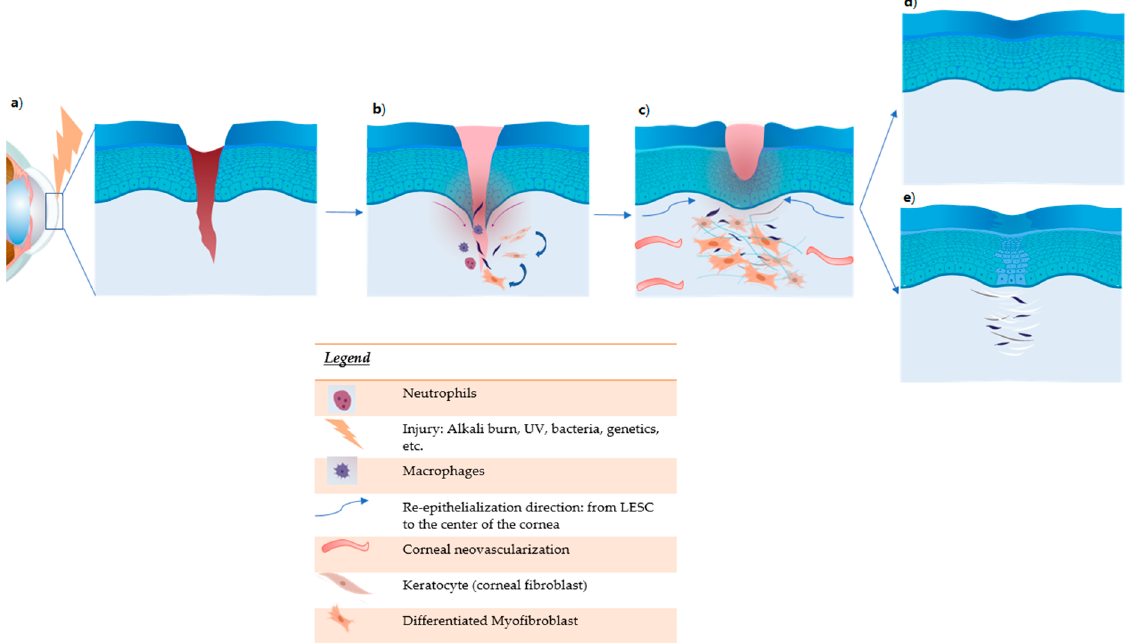
Figure 3. Corneal damage (deep injury) and wound healing. ( a ) Damage induces tissue necrosis and release of cytokines: TNF α , IL1, IL6, and PDGF. The acute phase of inflammation begins. ( b ) During inflammation, neutrophils and macrophages are recruited. They produce other inflammatory cytokines and chemokines. TGF-b induces the differentiation of fibroblasts into myofibroblasts. ( c ) Activation of limbal epithelial stem cells (LESC) proliferation. Remodeling of the stromal matrix due to MMP with vascular endothelial growth factor (VEGF)-induced vessel formation. ( d ) Treatment improves corneal damage with restoration of transparency. ( e ) In untreated cornea, tissue fibrosis with corneal opacity develops.